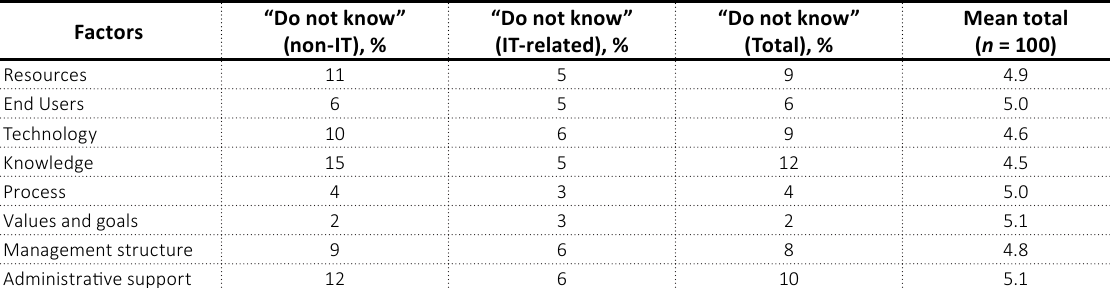
Table 13. Analysis of “Do not know” internal